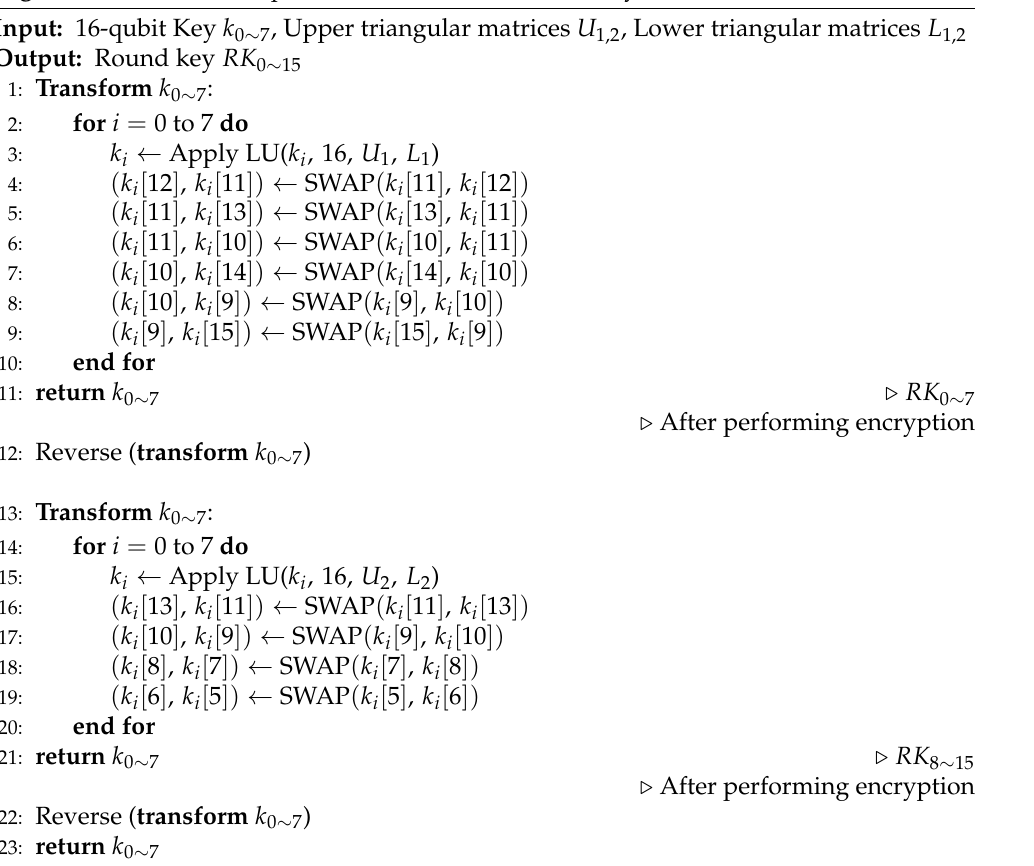
Figure 3. Quantum circuit of the CHAM-64/128 key schedule with PLU factorization (Apply_L), white circle indicates XOR operation and black dot indicates connection. Algorithm 2 Quantum implementation of CHAM-64/128 key-schedule with PLU